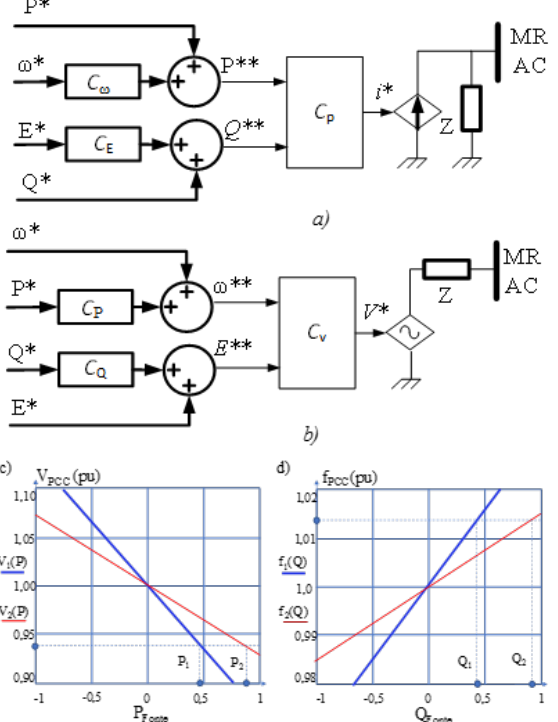
Figure 6. Model for Islanded Operation. ( a ) GSC current source. ( b ) GSC voltage source. ( c ) Droop active power (V × P). ( d ) Droop reactive power (f × Q).